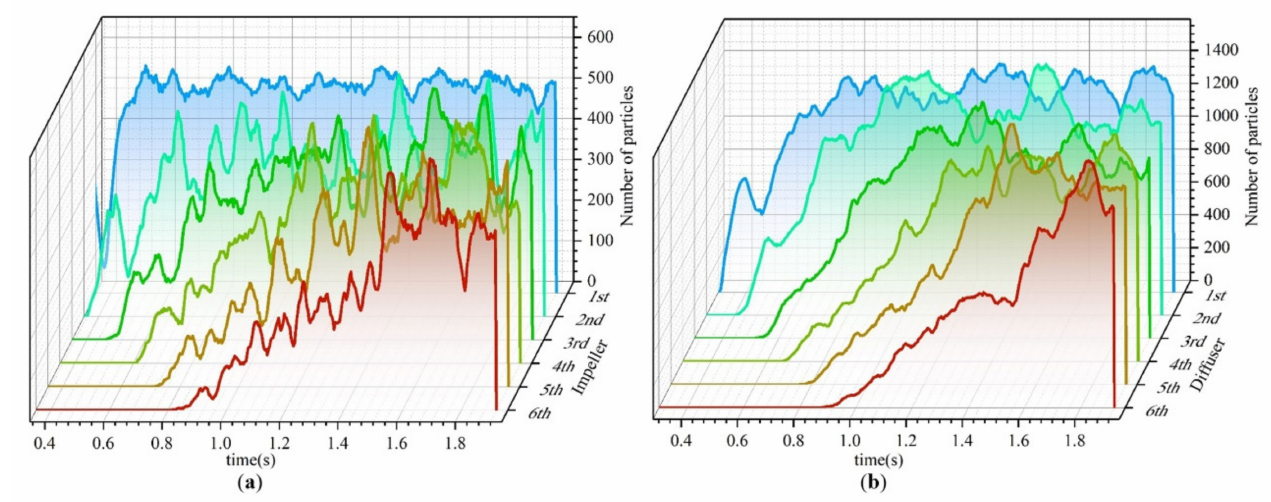
Figure 16. Total number of particles: ( a ) in six impellers; ( b ) in six